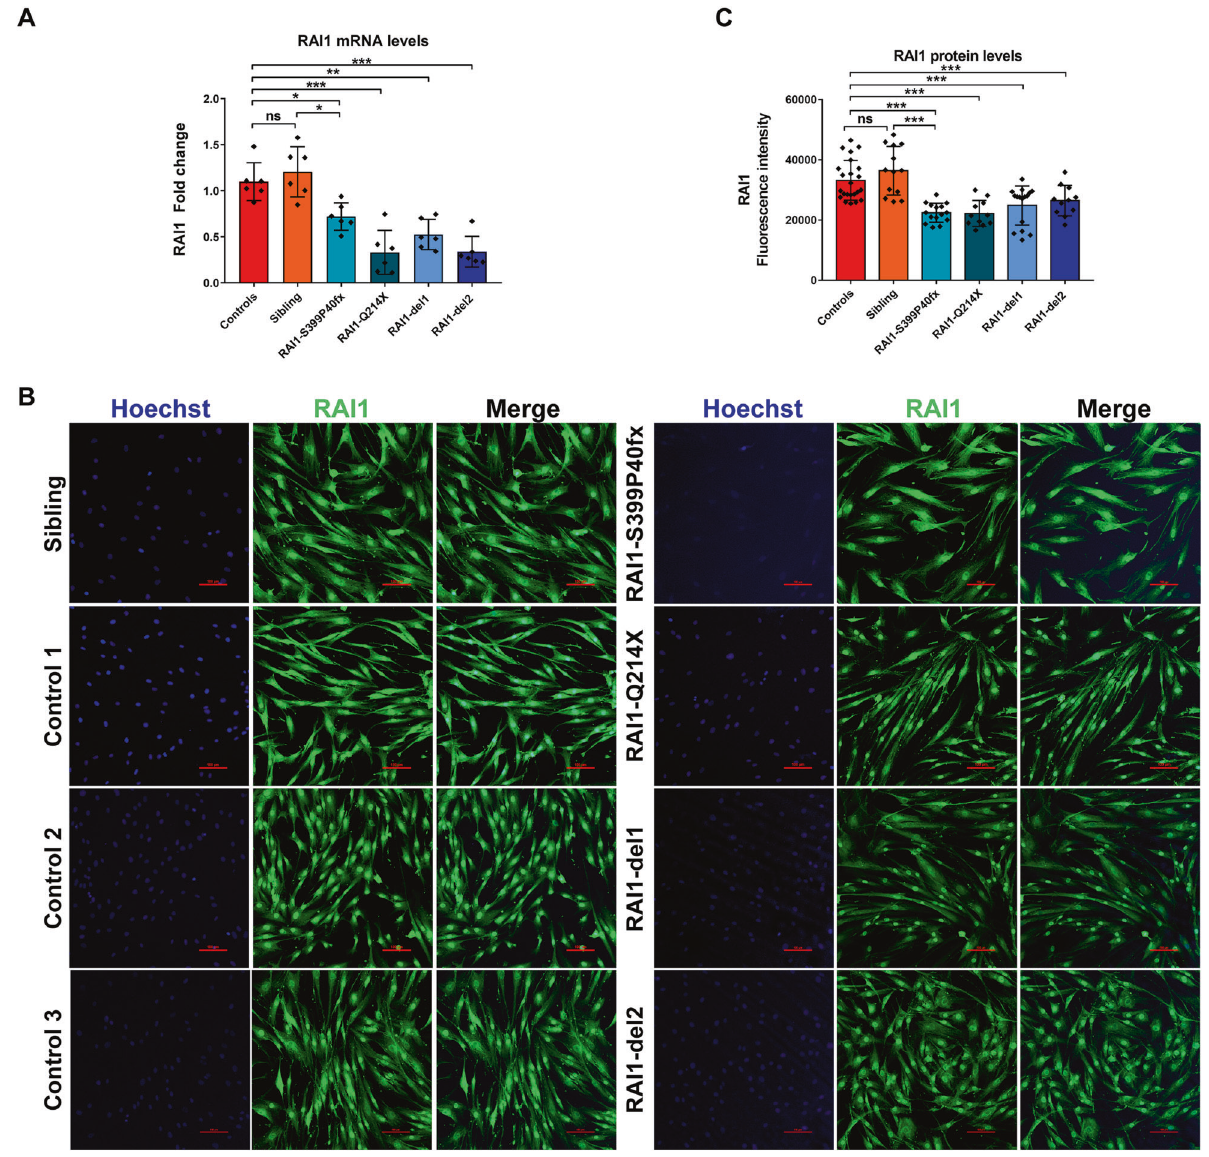
Fig. 1 Subcellular localization of RAI1 in SMS patient-derived cells. A The RT – PCR analysis of the transcript levels of RAI1 revealed reduced gene expression in SMS cells compared with control cells ( n = 6 – 7 biological replicates). B An immuno fl uorescence analysis of the subcellular localization of RAI1 in SMS and control cells revealed that wild-type and mutant RAI1 localize to the nucleus and cytosol. RAI1 (green) was detected using a speci fi c antibody, and nuclei were detected with Hoechst (blue) ( n = 3 biological replicates). Scale bar = 25 µm. Representative images are shown. C Densitometry showing the RAI1 levels ( n = 15 cells from 5 randomly selected fi elds from 3 independent experiments of each cell line). Graphs: mean ± SEM, one-way ANOVA + Newman – Keuls post hoc test, * p < 0.05, ** p < 0.01, *** p < 0.001, ns not signi fi